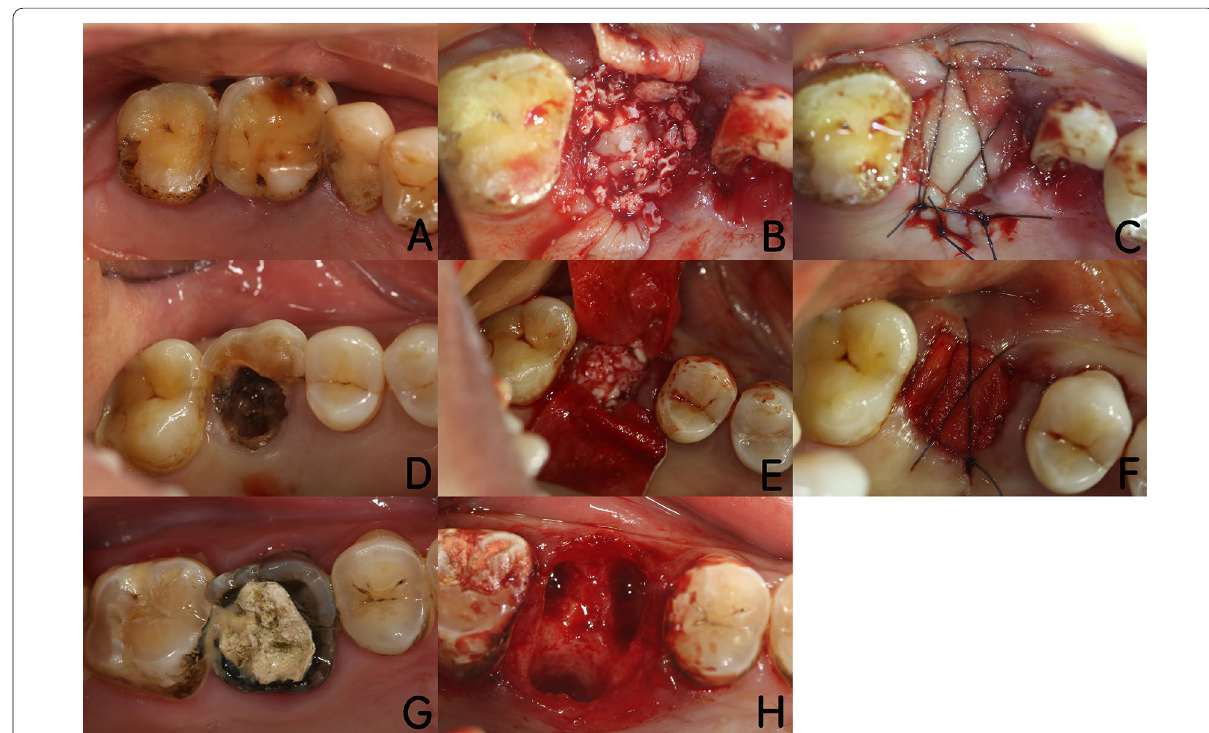
Fig. 1 Description of the operative process for the three groups. a – c CGFs/DBBM group. a Preoperative image for CGFs/DBBM group; b CGFs/ DBBM mixture implanted into the tooth socket; c covered with CGF membranes and sutured; d ‑ f : DBBM group, d preoperative image for DBBM group; e DBBM implanted into the tooth socket; f covered with Bio‑Gide ® membranes and sutured. g – h control group, g preoperative image for control group; h nothing